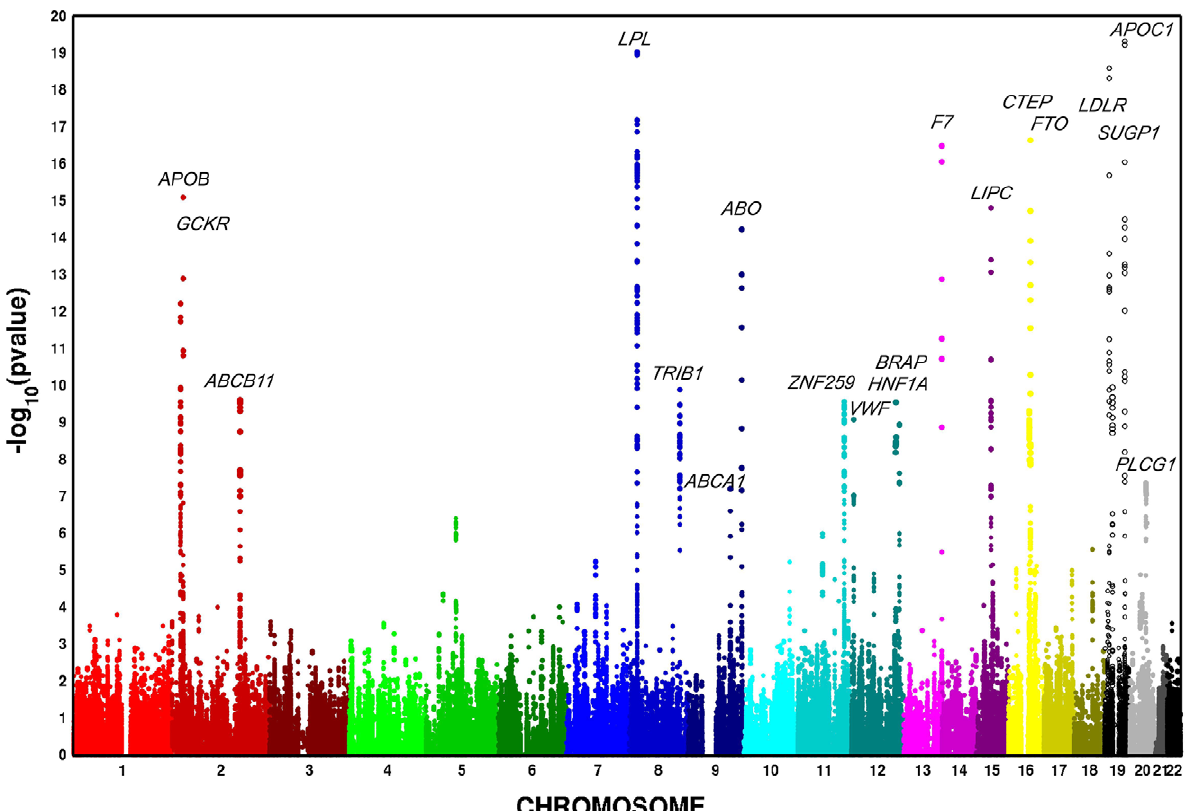
Figure 2. Multivariate association scan of the metabolic syndrome in n=19,468 European American participants from five cohorts. Y-axis P –values are truncated at 1 6 10 2 20 .